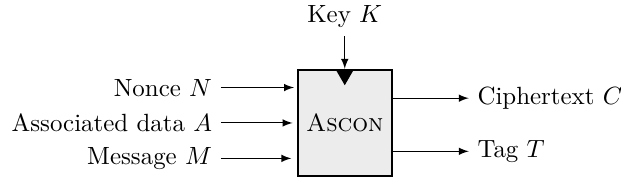
Figure 1: The high-level structure of the encryption algorithm of